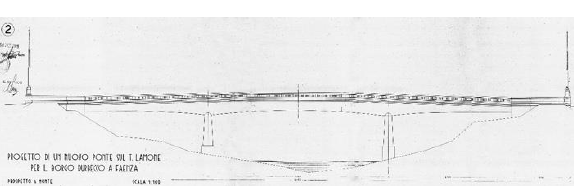
Figure 3. The elevation of “Ponte delle Grazie” in the original drawings from “Archivio di Stato di Faenza”.